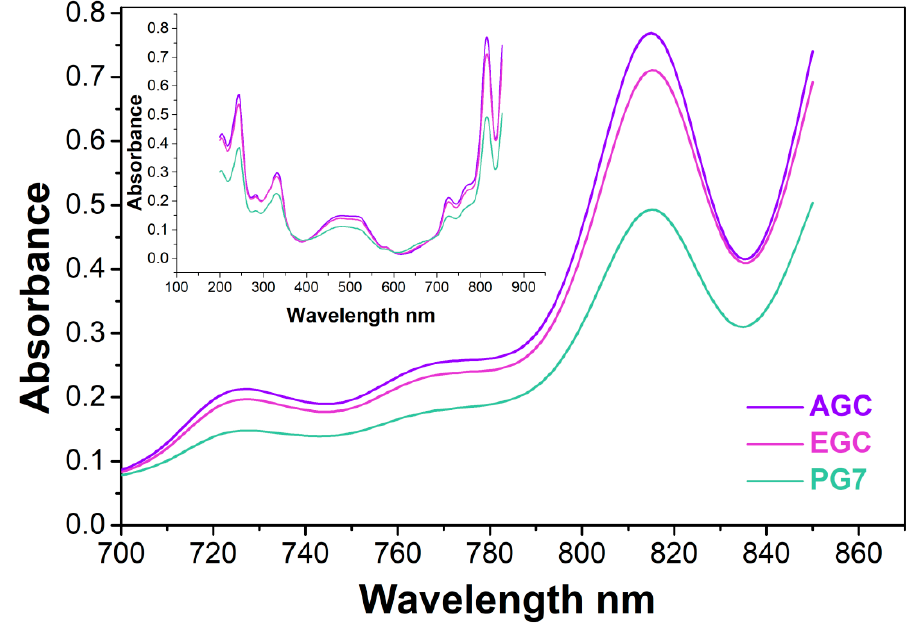
Figure 2. UV–Vis spectra of AGC, EGC and PG7 dissolved in concentrated sulfuric acid in the range 700–850 nm. The spectra in the whole 200–850 nm range are reported in the inset. AGC, EGC and PG7 all show absorptions at 283 nm, 331 nm, around 500 nm (broad), 579 nm, 675 nm (shoulder), 729 nm, 770 nm (shoulder) and 815 nm. These spectral features registered in sulfuric acid are identical to the ones observed by [44] although the most